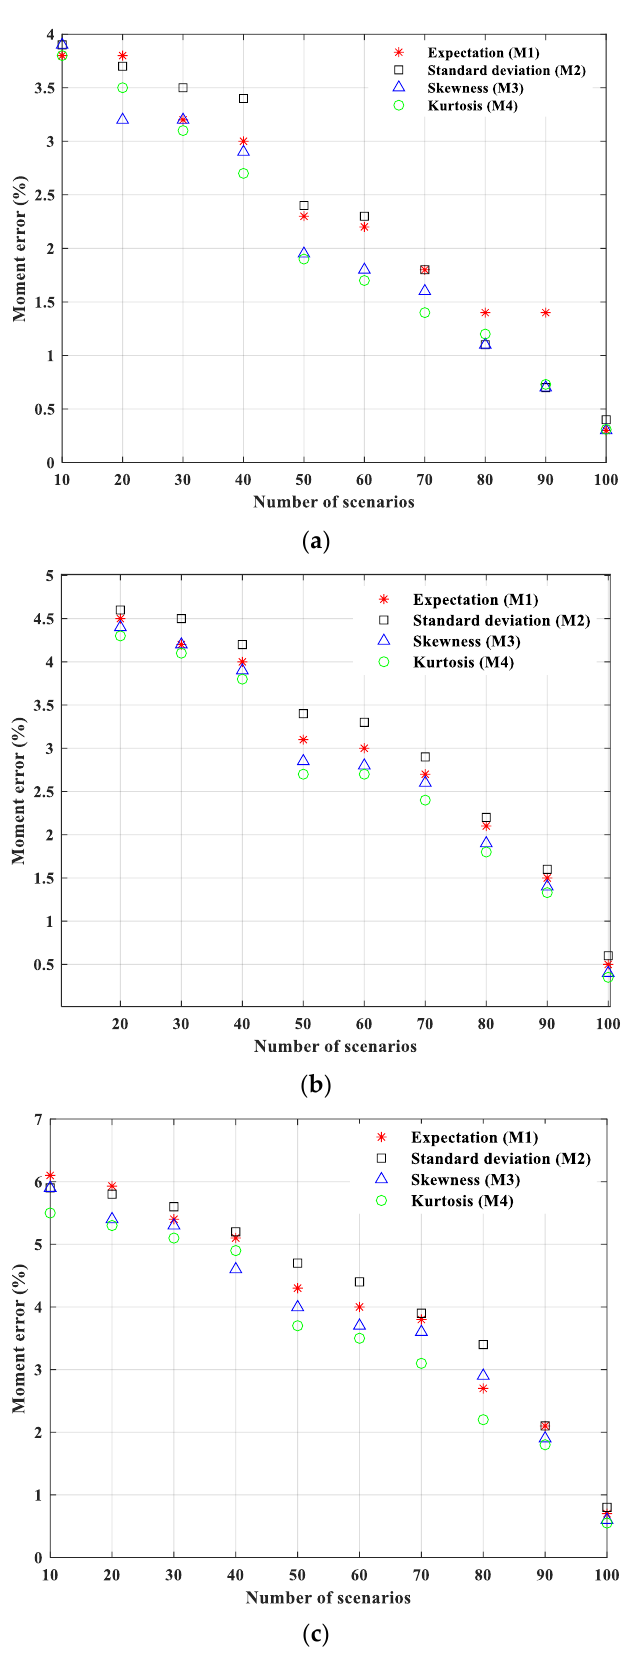
Figure 7. Amounts of moment errors between the historical data and generated scenarios for: ( a ) Scenario 1 (SC1); ( b ) SC2; ( c ) SC3.